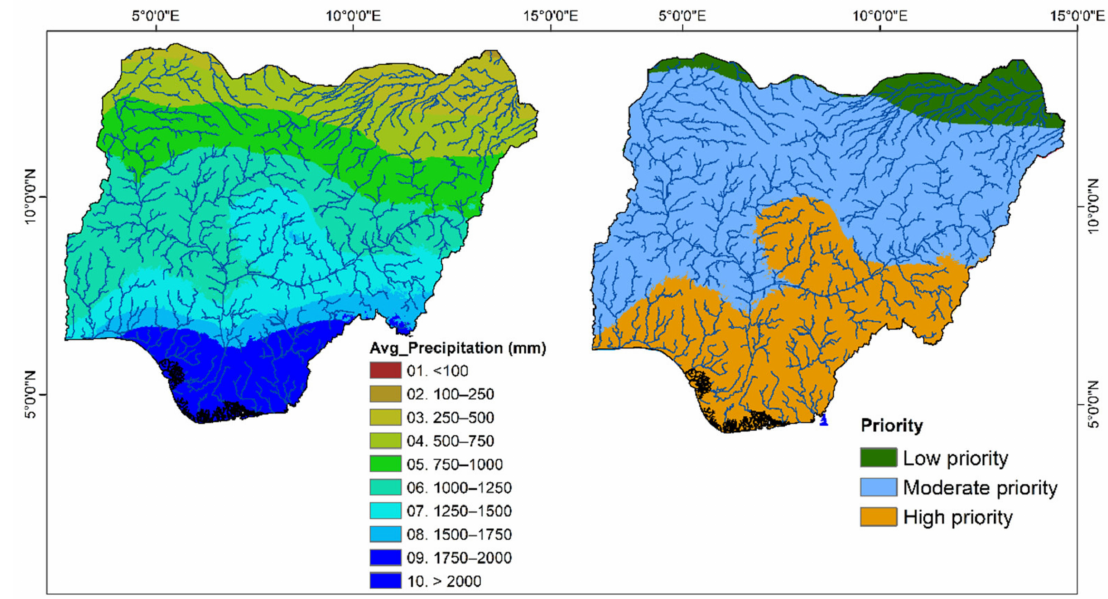
Figure 6. Mean annual rainfall in Nigeria (TerraClimate).